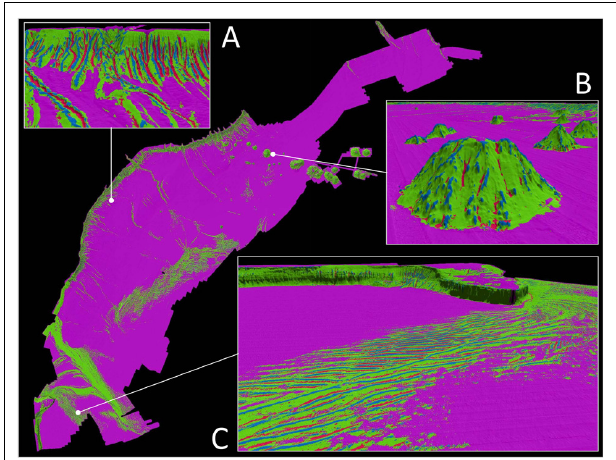
FIGURE 4 | Continuous coverage landform map of the Atlantic Margin study region classified into four landform types: flats (purple), slopes (green), ridges (blue), and valleys (red). Oblique 3-D inset views of landform type draped on bathymetry provided to show details. Note the clear delineation of canyon ridges, valleys, and steep slopes on the continental slope (A) . Seamount features are dominated by very steep slopes with occasional ridge and valley features (B) . Several large regions of the abyssal plains exhibit bedform features that follow a distinct pattern of repeating crest and trough (slope and ridge landform) combinations. Bottom right inset highlights one of these bedform fields east of the prominent Blake Spur feature (C) . Figure made with QPS Fledermaus software version 7.7.9. with vertical exaggeration of 4 × .